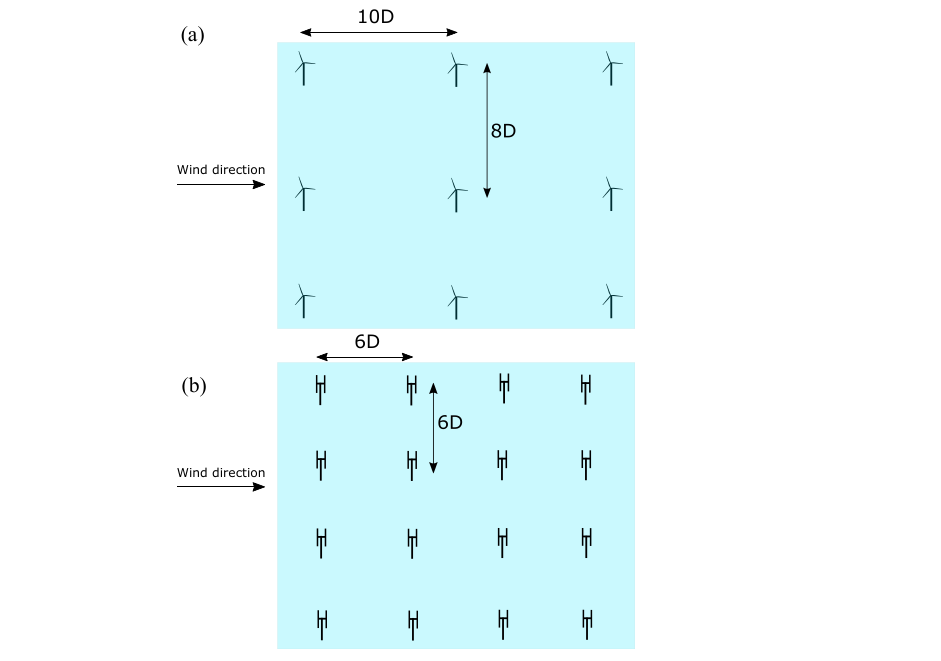
Figure 4. Wind farm spacing layout of ( a ) HAWTs and ( b ) VAWTs, considering wake recovery requirements and assuming uniform wind